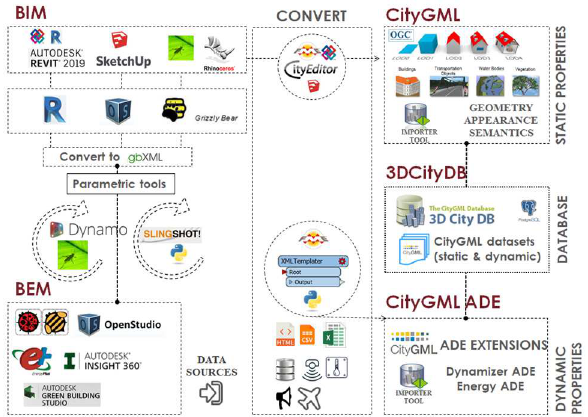
Figure 1. methodological approaches and tools’ flowchart for